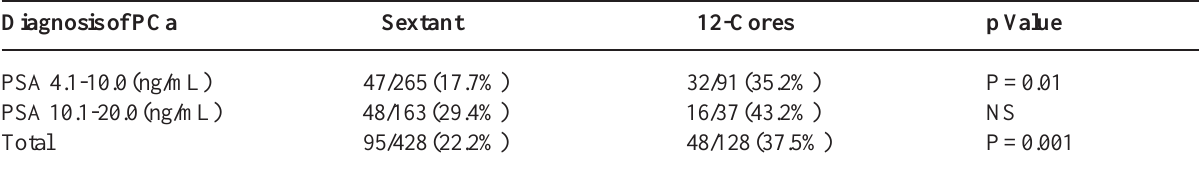
Table 2 – Diagnostic rates of prostate cancer in sextant and 12-core biopsy groups.